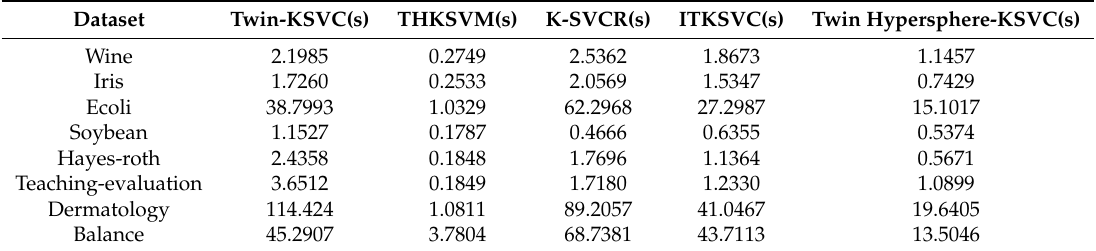
Table 4. Learning time of THKSVM, ITKSVC, Twin-KSVC, K-SVCR and Twin Hypersphere-KSVC on UCI benchmark datasets.